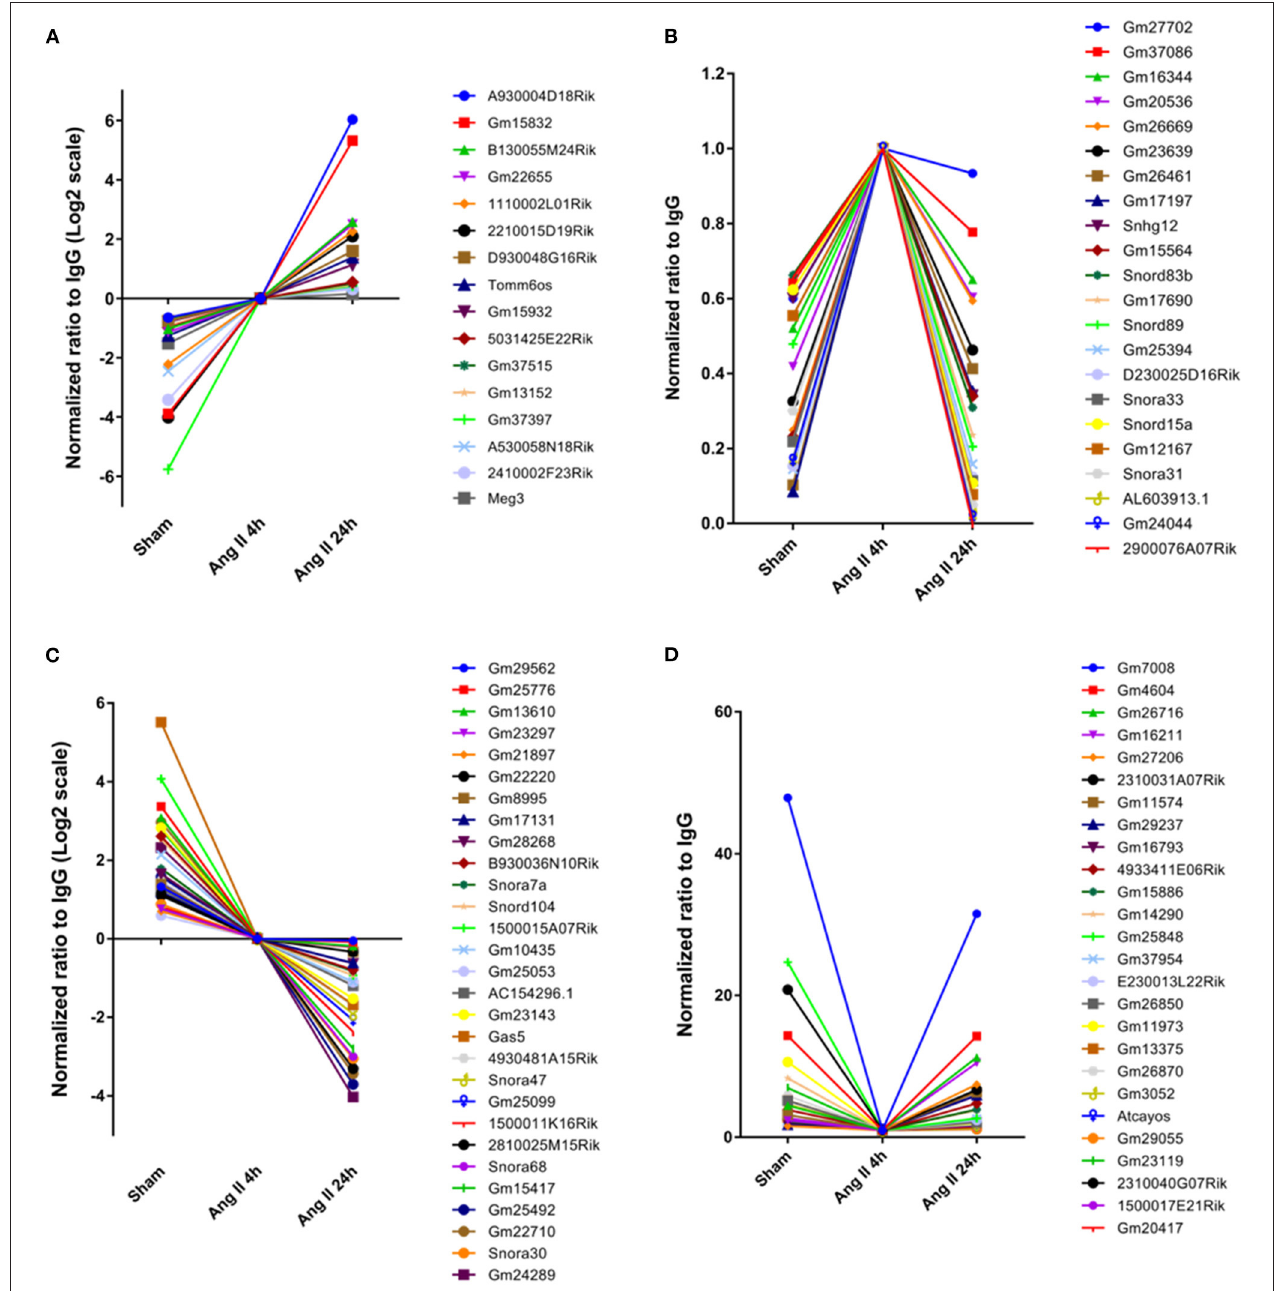
FIGURE 3 | Stratification of EZH2-associated ncRNAs according to their changing pattern after AngII treatment. (A) Constantly enhanced EZH2-binding ncRNAs in both AngII 4 and 24h groups. (B) Transiently enhanced EZH2-binding ncRNAs after 4h of AngII treatment but attenuated after 24h of AngII treatment. (C) Constantly suppressed EZH2-binding ncRNAs in both AngII 4 and 24h groups. (D) Transiently suppressed EZH2-binding ncRNAs after 4h of AngII treatment but reversed after 24h of AngII treatment. Data were normalized to the AngII 4h